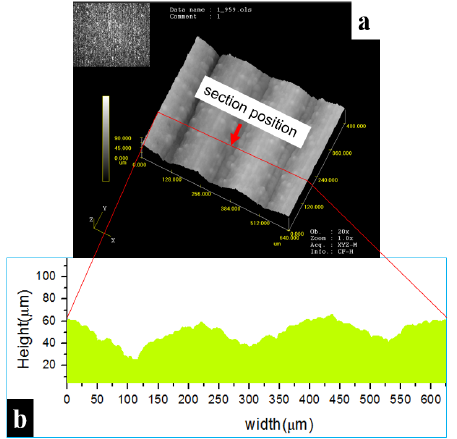
Figure 4. Confocal laser scanning microscopy (CLSM) photographs of the PCL surface. ( a ) The 3D morphology of the periodic sub-millimetre ridge structure and the selected cross section position to be studied; ( b ) the section topography and dimension information of the ridge structure, papillae and eye hair structure near the stomata.